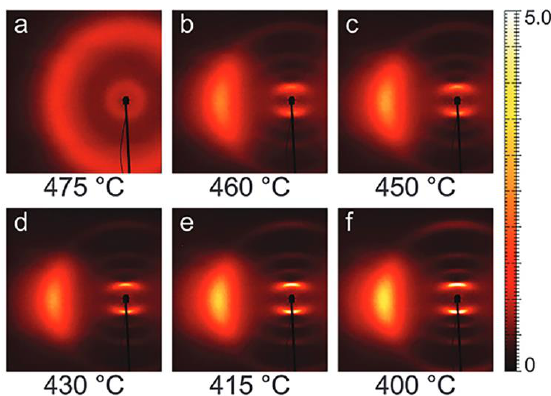
Figure 14. 2,6-biphenyl naphthalene (PPNPP) wide-angle diffraction patterns measured on cooling from the isotropic melt upon application of an aligning magnetic field (2.2 T, vertical). Only the left wide-angle feature is shown because of the pattern symmetry. Reproduced from [59] with permission from The Royal Society of Chemistry.